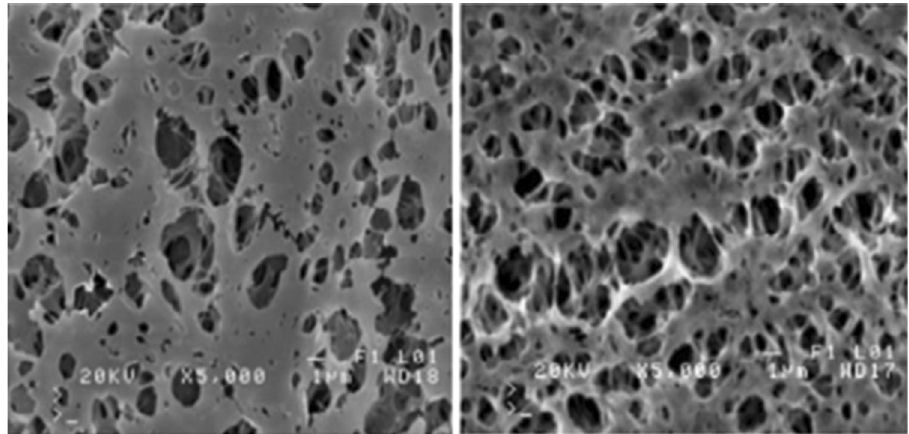
Fig. 15 Influence of feed temperature and kind of used membranes on the permeate flux and thermal efficiency feed-distilled water T D = 20 °C, 3 m m F = D = 0.014 dm